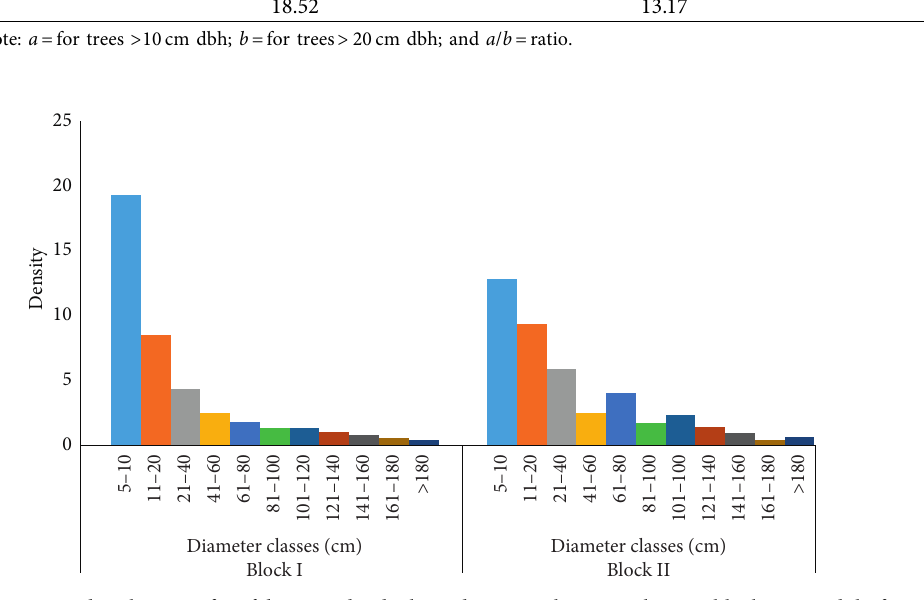
Figure 4: Density distribution of P. falcatus individuals in diameter classes in the two blocks in Dodola forest.